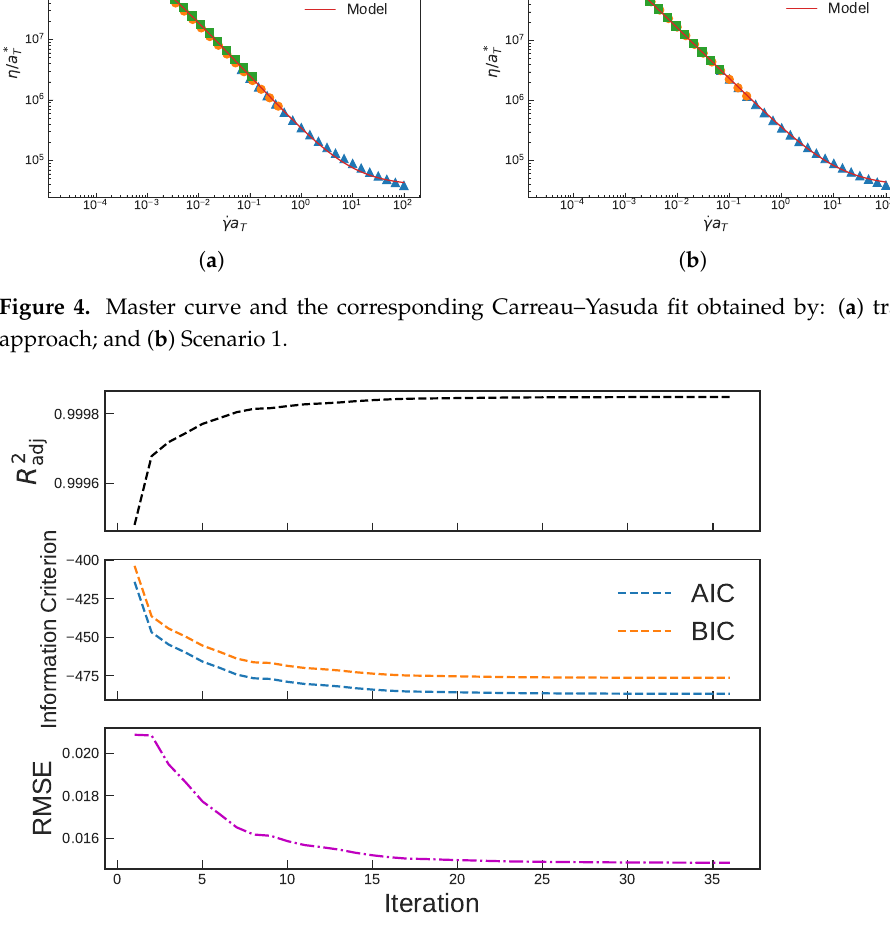
Figure 5. Evolution of various goodness-of-fit values (Scenario 1).